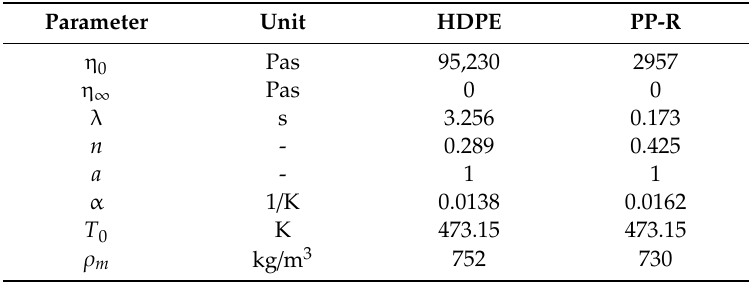
Table 2. Material properties ( ρ m is the melt density at 200 ◦ C and 200 bar).